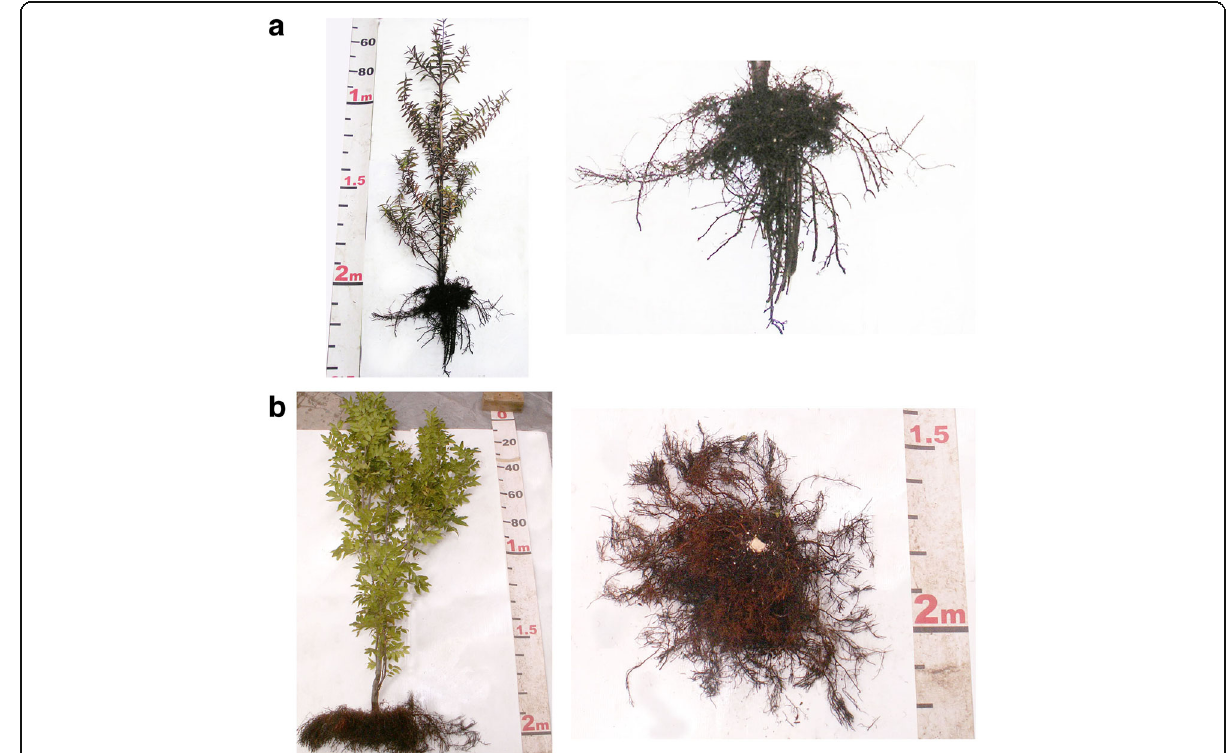
Fig. 2 Vertical and plan views of 5-year-old Agathis australis ( a ) and Alectryon excelsus ( b ) root systems